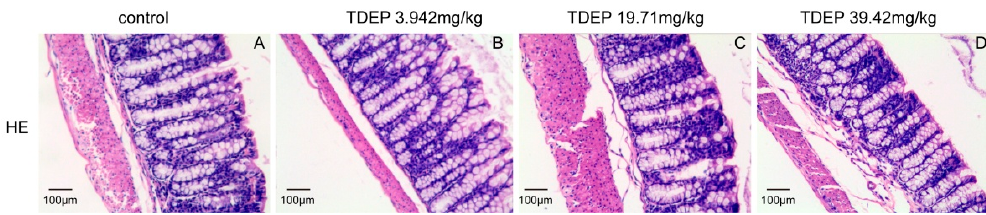
Figure 3. Effect of TDEP on the histological morphology of mouse colon by HE staining. Normal mice ( A ); mice administered with TDEP (3.942 mg/kg) ( B ); mice administered with TDEP (19.71 mg/kg) ( C ); mice administered with TDEP (39.42 mg/kg) ( D ).